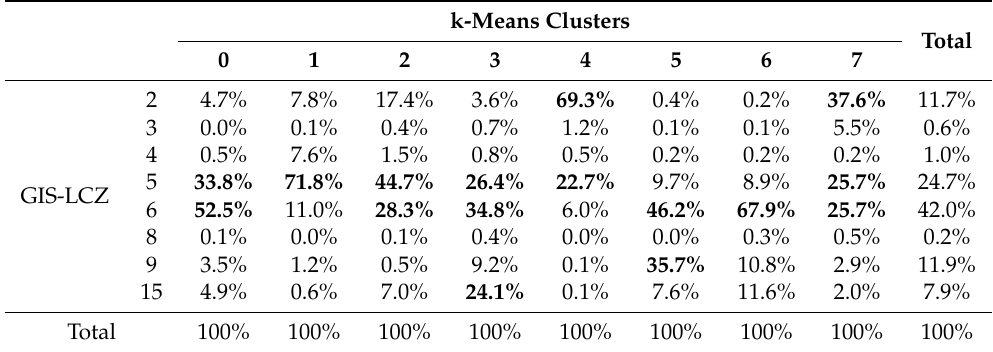
Table 6. Crosstab between GIS-LCZ classes and k-mean clusters (numbers in bold font are above